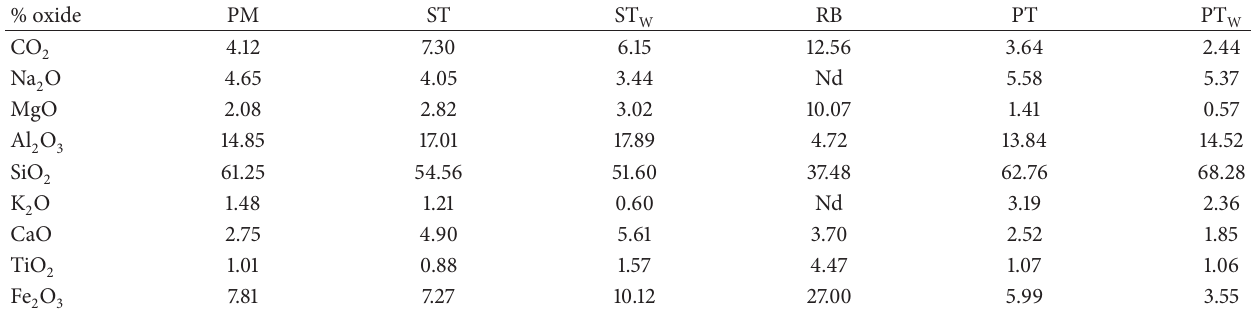
Table 1: EDS data for volcanic pyroclastic mixture (PM) and selected typical components.